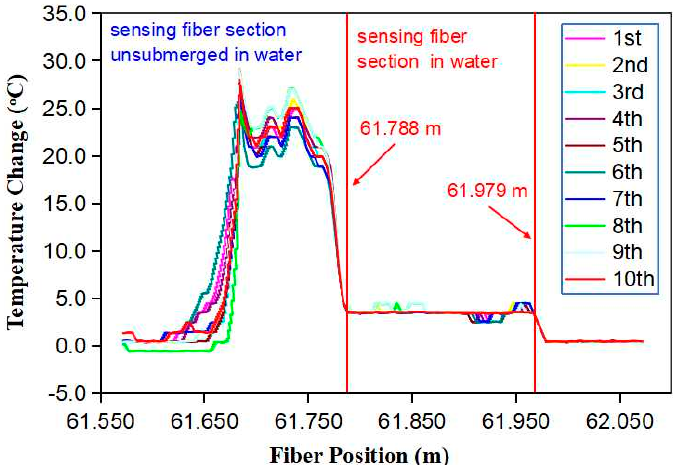
Figure 9. The sensor measured the interface between the water and air consecutively 10 times when the fiber was heated electrically with a 400-mA current.which are consistent.